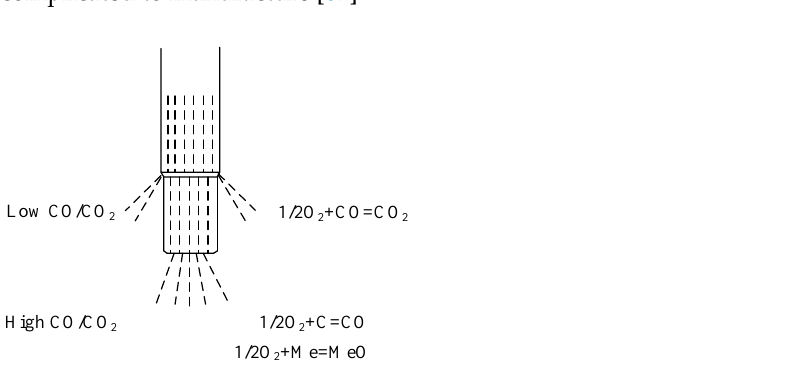
Figure 4. Schematic diagram of a secondary combustion oxygen lance.